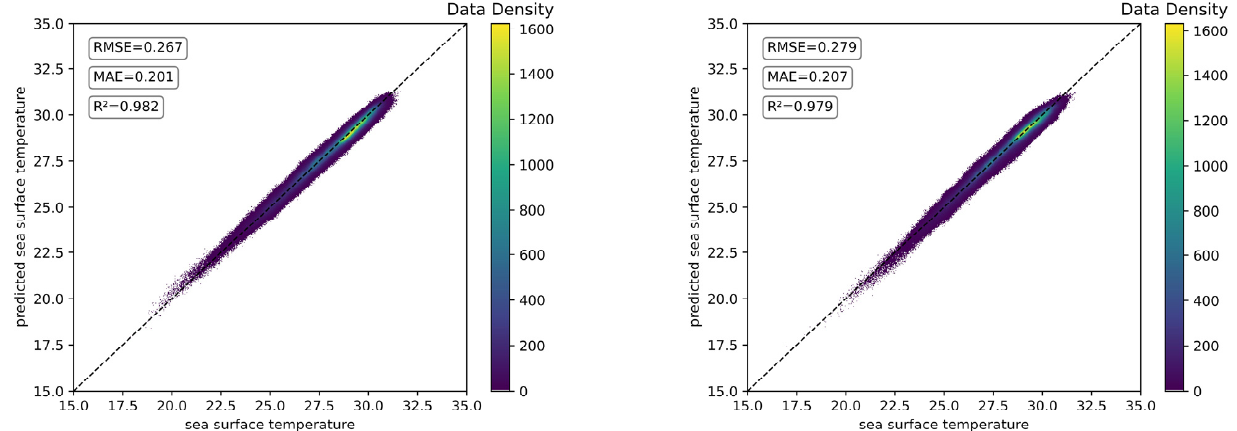
Figure 7. Comparison of SST prediction performance using ST-ConvLSTM. On the left, the input length is set to 1, and on the right, it is set to 30.